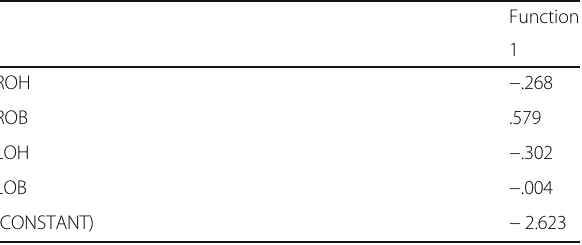
Table 4 Canonical discriminant function coefficients